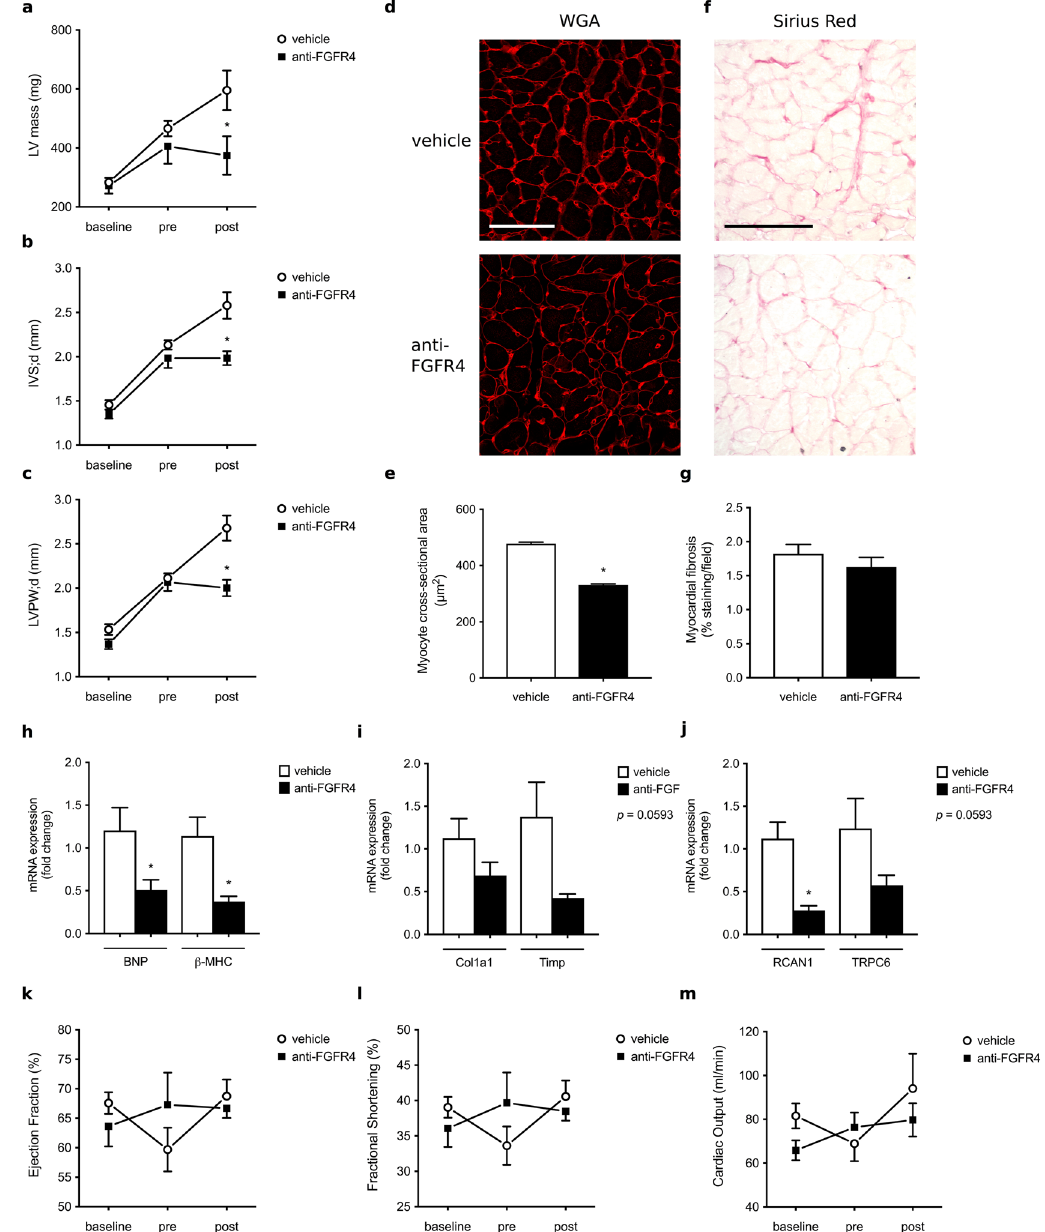
Figure 4. FGFR4 blockade inhibits the progression of LVH in the 5/6 nephrectomy rat model of CKD. ( a – c ) Cardiac parameters of 5/6 nephrectomized rats were evaluated by echocardiography at baseline, four weeks (pre) and eight weeks after surgery (post). All 5/6 nephrectomized animals develop LVH four weeks post-surgery, but anti-FGFR4 treatment prevents the progression of cardiac remodeling when compared to vehicle-treated rats. ( d ) Representative images of WGA-stainings of the LV free wall (original magnification x63, scale bar 70 µ m). ( e ) Cross-sectional area of 25 myocytes per field of 4 fields along the LV free wall. ( f ) Representative Picrosirius Red stainings of the LV free wall (original magnification x20, scale bar 100 µ m). ( g ) Quantification of myocardial fibrosis based on positive Picrosirius Red labeling (8 fields of view around the LV). ( h , i , j ) Quantitative real-time PCR analysis of cardiac tissue using GAPDH as a house keeping gene. mRNA levels of hypertrophic markers (BNP, β -MHC) and the NFAT target gene RCAN1 are significantly decreased in anti-FGFR4 treated rats when compared to vehicle-injected animals. Fibrosis markers (Col1a1, Timp) and the NFAT target gene TRPC6 show a trend towards a decrease upon FGFR4 blockade (p = 0.0593). ( k , l , m ) Cardiac function remains unchanged upon induction of CKD as well as before and after administration of anti-FGFR4. No significant differences were found in ejection fraction, fractional shortening and cardiac output over time. All values are mean ± SEM (n = 6–8 per group; * p <